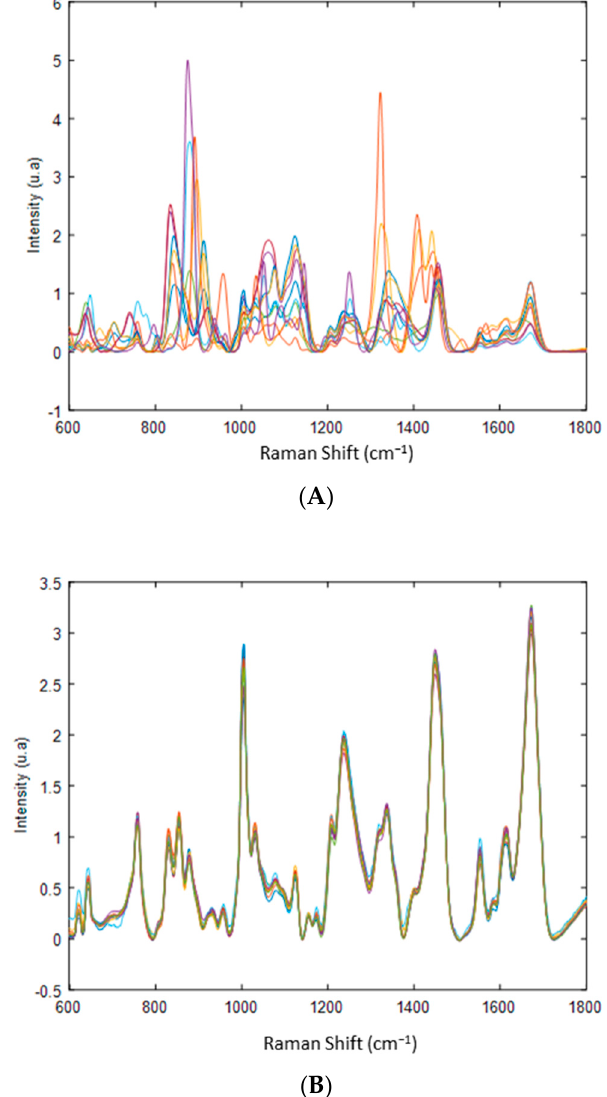
Figure 1. ( A ) Preprocessed Raman spectra of therapeutic proteins in their pharmaceutical formulation. ( B ) Preprocessed Raman spectra recorded after removal of residual salts and excipients present in the formulations of therapeutic proteins using size exclusion spin columns. Baseline correction and standard normal variate (SNV) were applied as preprocessing.